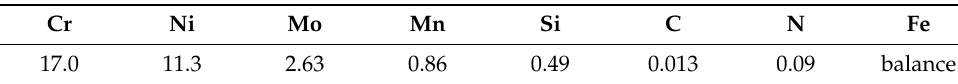
Table 2. Chemical composition of 316L SS powder